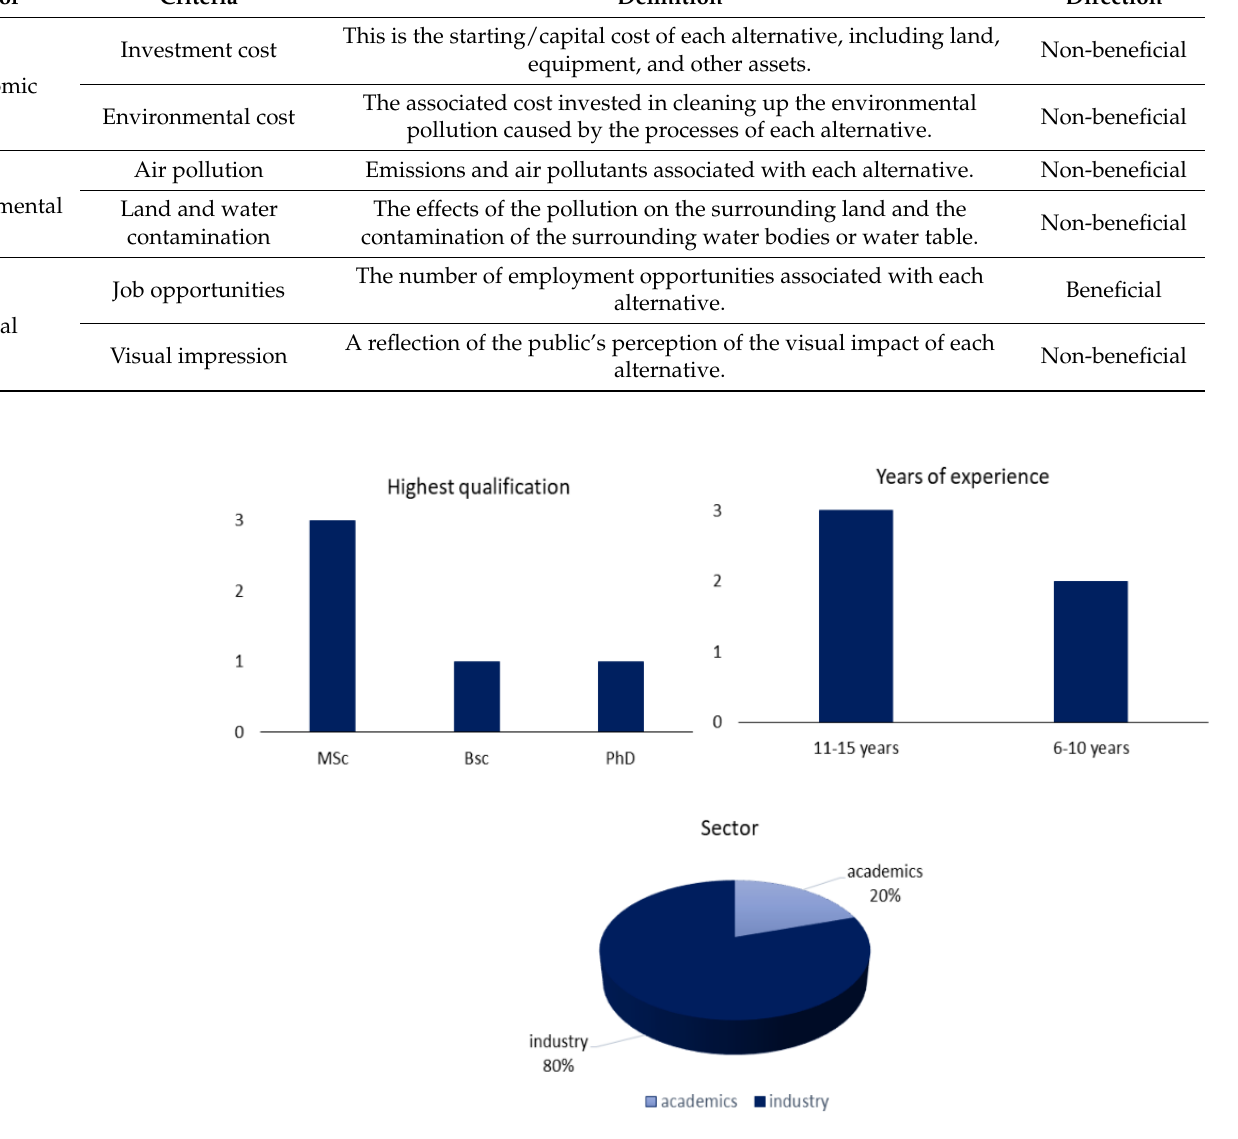
Figure 2. The professional and educational details of experts. Table 4. The intuitionistic fuzzy decision matrix and the aggregated experts’ opinions and judgments.